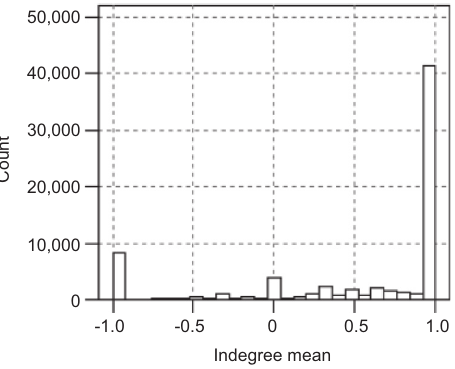
Figure 2. Distribution of Indegree Mean for Slashdot.